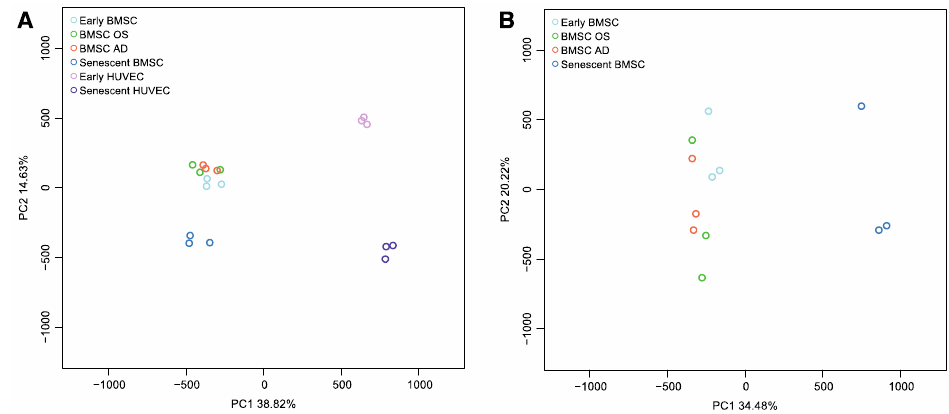
Figure 2. Principal Component Analysis (PCA) of DNAm values obtained by genome-wide analysis ( A ) in early and senescent HUVEC and in early, senescent, and differentiated BMSC samples, and ( B ) in early, senescent, and differentiated BMSC samples ( n = three replicates per condition). The percentage of variance explained by the first and the second principal components is reported in X and Y axes, respectively.